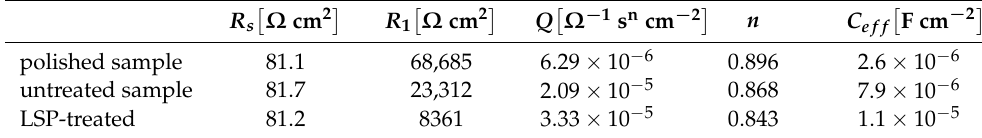
Table 3. Equivalent circuit parameters used for estimation of the roughness factor.